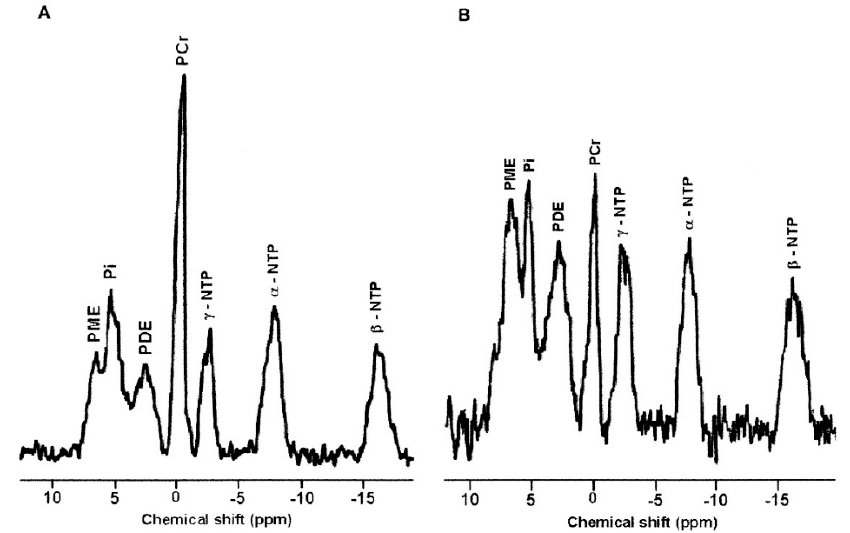
Figure 4. ( A , B ): T2-weighted sagittal MR image showing the voxel location from a malignant lesion and the corresponding 1 H MR spectrum acquired from 20 × 20 × 20 mm 3 voxel. ( C , D ): Dynamic contrast-enhanced axial MR image showing the voxel location from a benign tumor and the corre- sponding spectrum acquired from 10 × 11 × 15 mm 3 voxel. ( E , F ): T2-weighted sagittal MR image showing the voxel location from normal breast tissue and the corresponding 1 H MR spectrum ac- quired from 15 × 15 × 15 mm 3 voxel (Reproduced with permission from John Wiley & Sons, Inc. (Hoboken, NJ, USA) from Reference [42]).